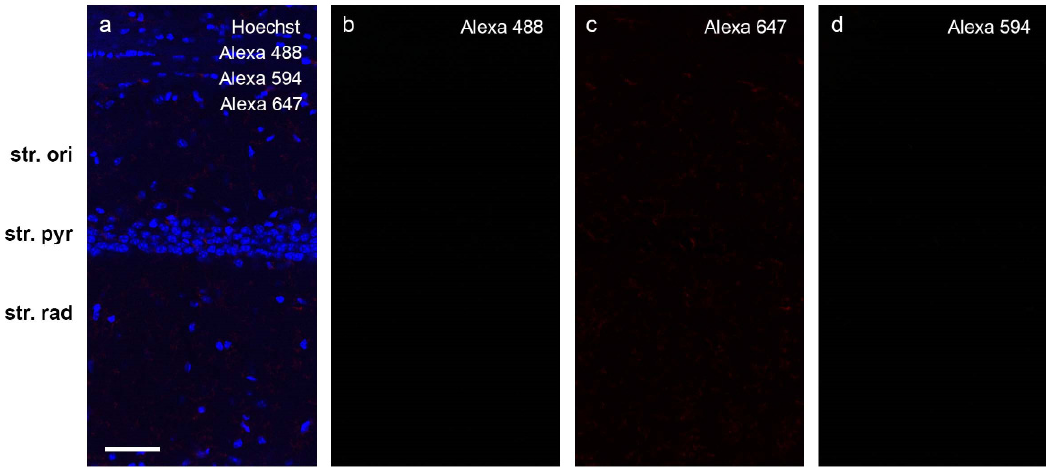
Figure 12. The omission of the primary antibodies resulted in complete absence of the immunore- activity. Mouse hippocampal tissue was labeled with ( a ) Hoechst 33,342 (blue); ( b ) goat anti-rabbit Alexa 488 (green); ( c ) goat anti-mouse Alexa 647 (red); and ( d ) goat anti-guinea pig Alexa 594 (yellow). Scale bar = 50 µ